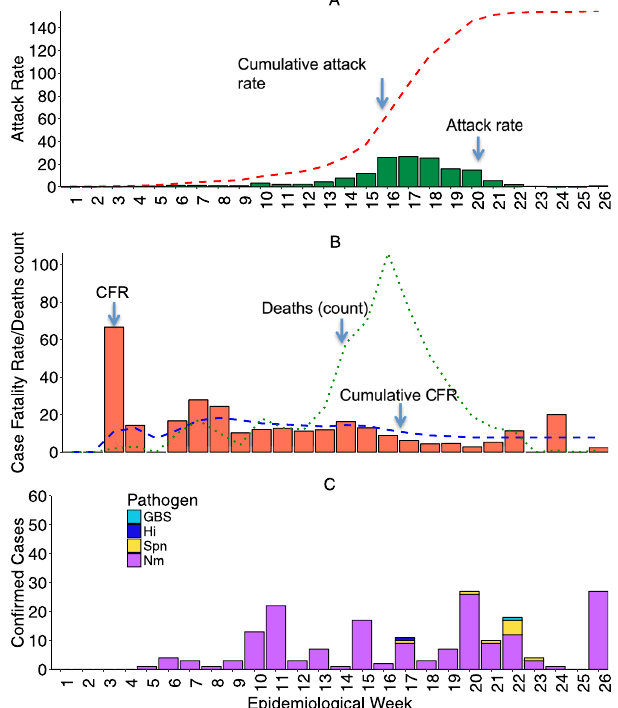
Figure 3. Epidemiologic curve of the meningitis outbreak in Zamfara State. The attack rates ( A ), case fatality rates ( B ) and laboratory-confirmed cases ( C ) by epidemiologic week. The distribution of pathogens detected among laboratory-confirmed cases is shown in ( C